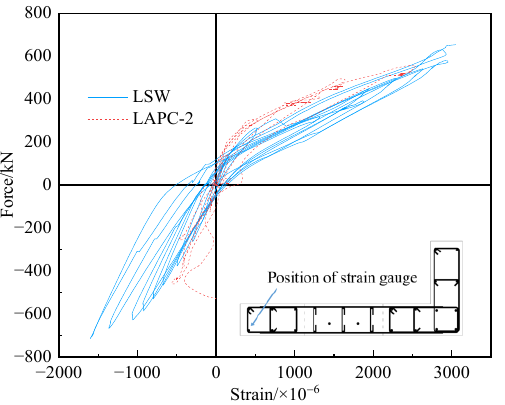
Figure 13. Force – strain curves of the outermost longitudinal rebars of the straight-edge members of specimens LSW and LAPC-2 at the position of 10 mm above the base beam.